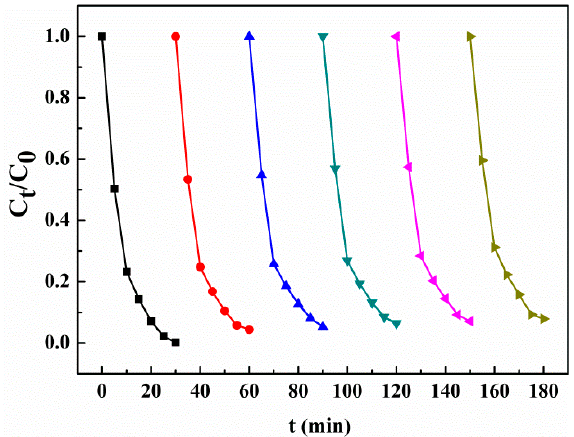
Figure 12. The cycling runs of MB degradation in the photo ‐ Fenton system catalyzed with Ag/AgCl/MIL ‐ 101(Fe).